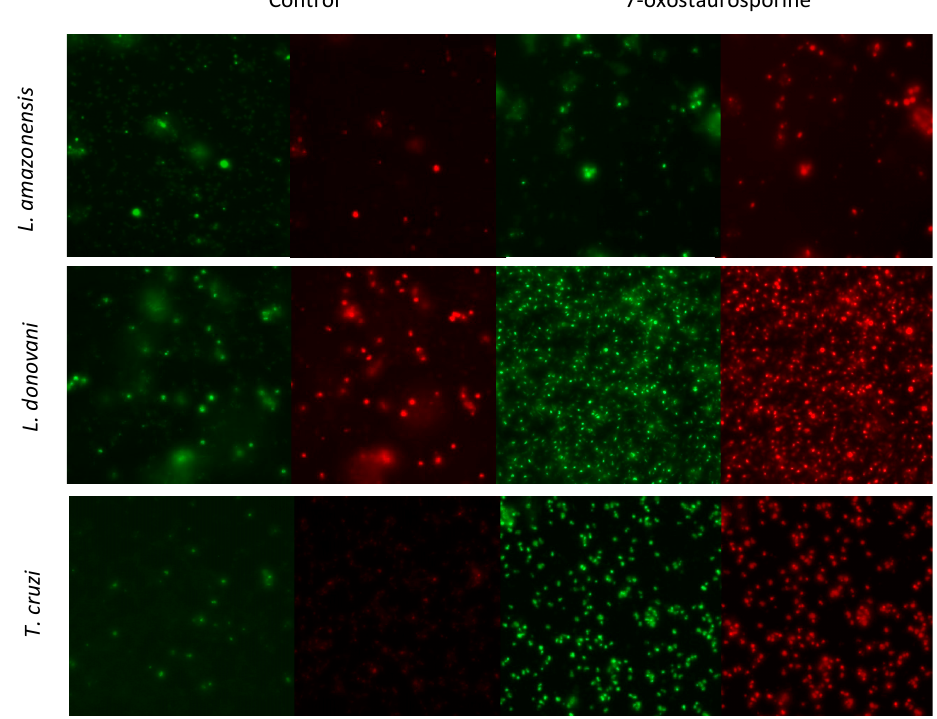
Figure 4. SYTOX Green (green) and propidium iodide (red) stainings in control and treatment with 7OSTS ( 2 ) on the three different strains after 24 h. Images taken by EVOS FL inverted microscope (Invitrogen) (40X).